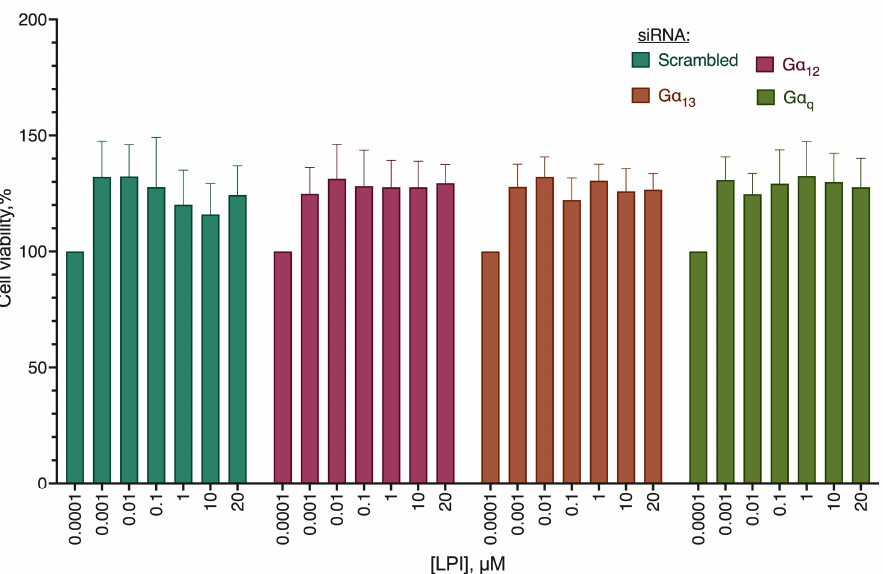
Figure 17. Stimulation of MDA ‐ MB ‐ 231 proliferation against the background of knockdown of G α subunits. Incubation with siRNA 72 h. Incubation with substance 72 h. MTT test data, mean±stand ‐ ard error, amalgamated data of n = 4 experiments.